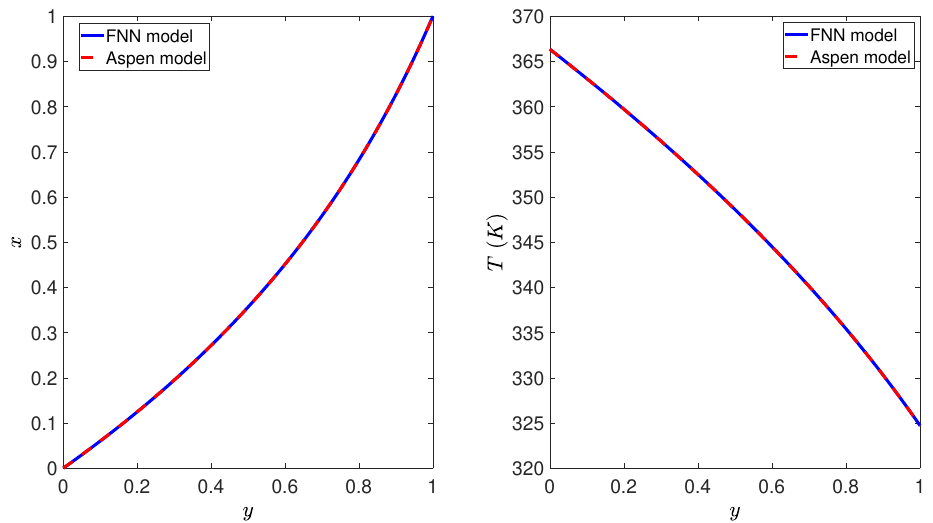
Figure 10. Comparison of the neural network model and the Aspen model.